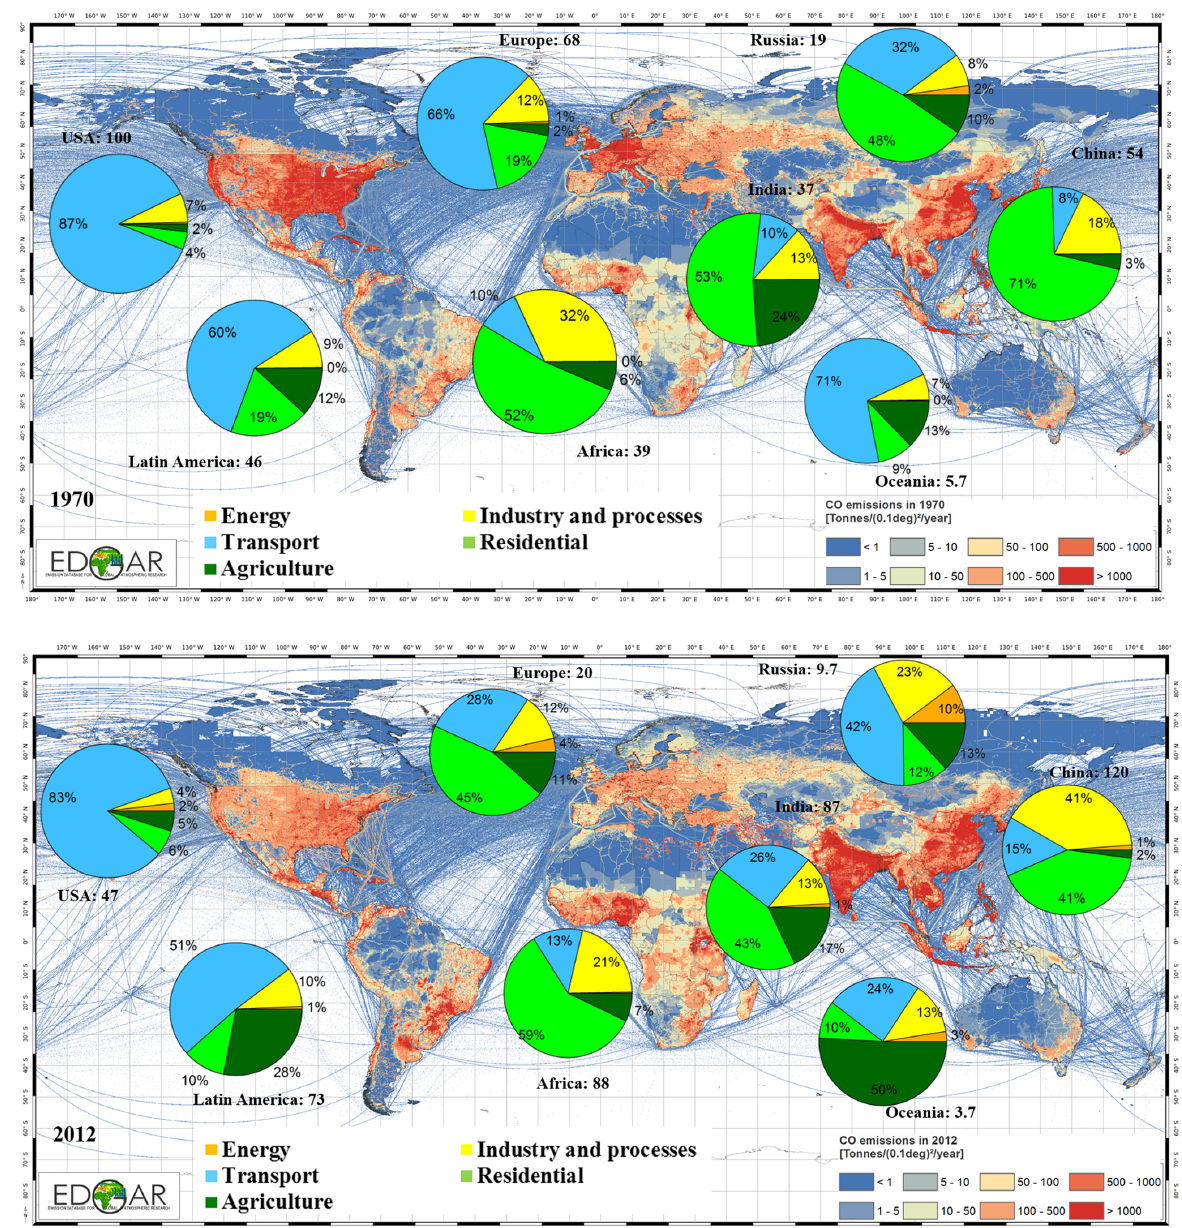
Figure 2. CO emission grid maps and relative contribution of aggregated EDGAR sectors (energy, industry and processes, transport, resi- dential, and agriculture) in world regions (pie charts) for 1970 and 2012. Total emissions (in Mtyr − 1 ) by region are also reported next to each pie